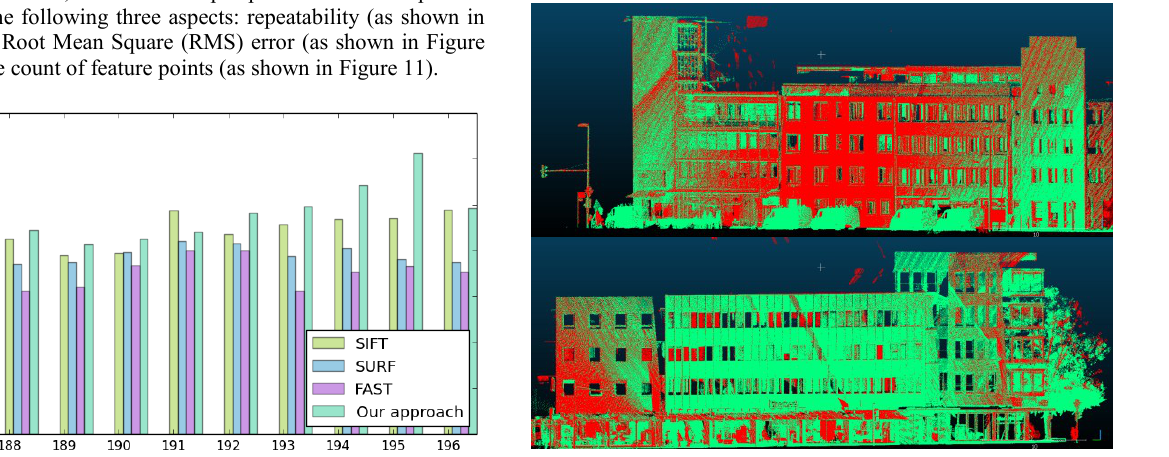
Figure 12. The aligned point cloud using our approach (aligned point cloud in red, reference point cloud in green, both sides of the